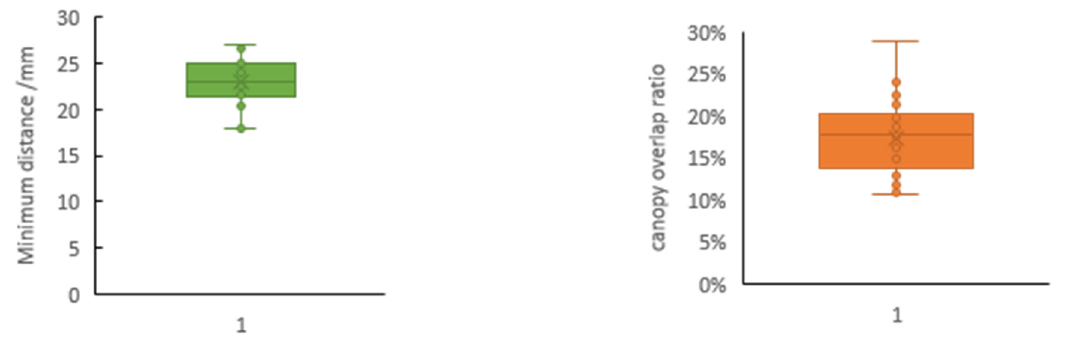
Figure 10. Minimum distance and maximum canopy overlap ratio detection results by the YOLO V4-Tiny model.